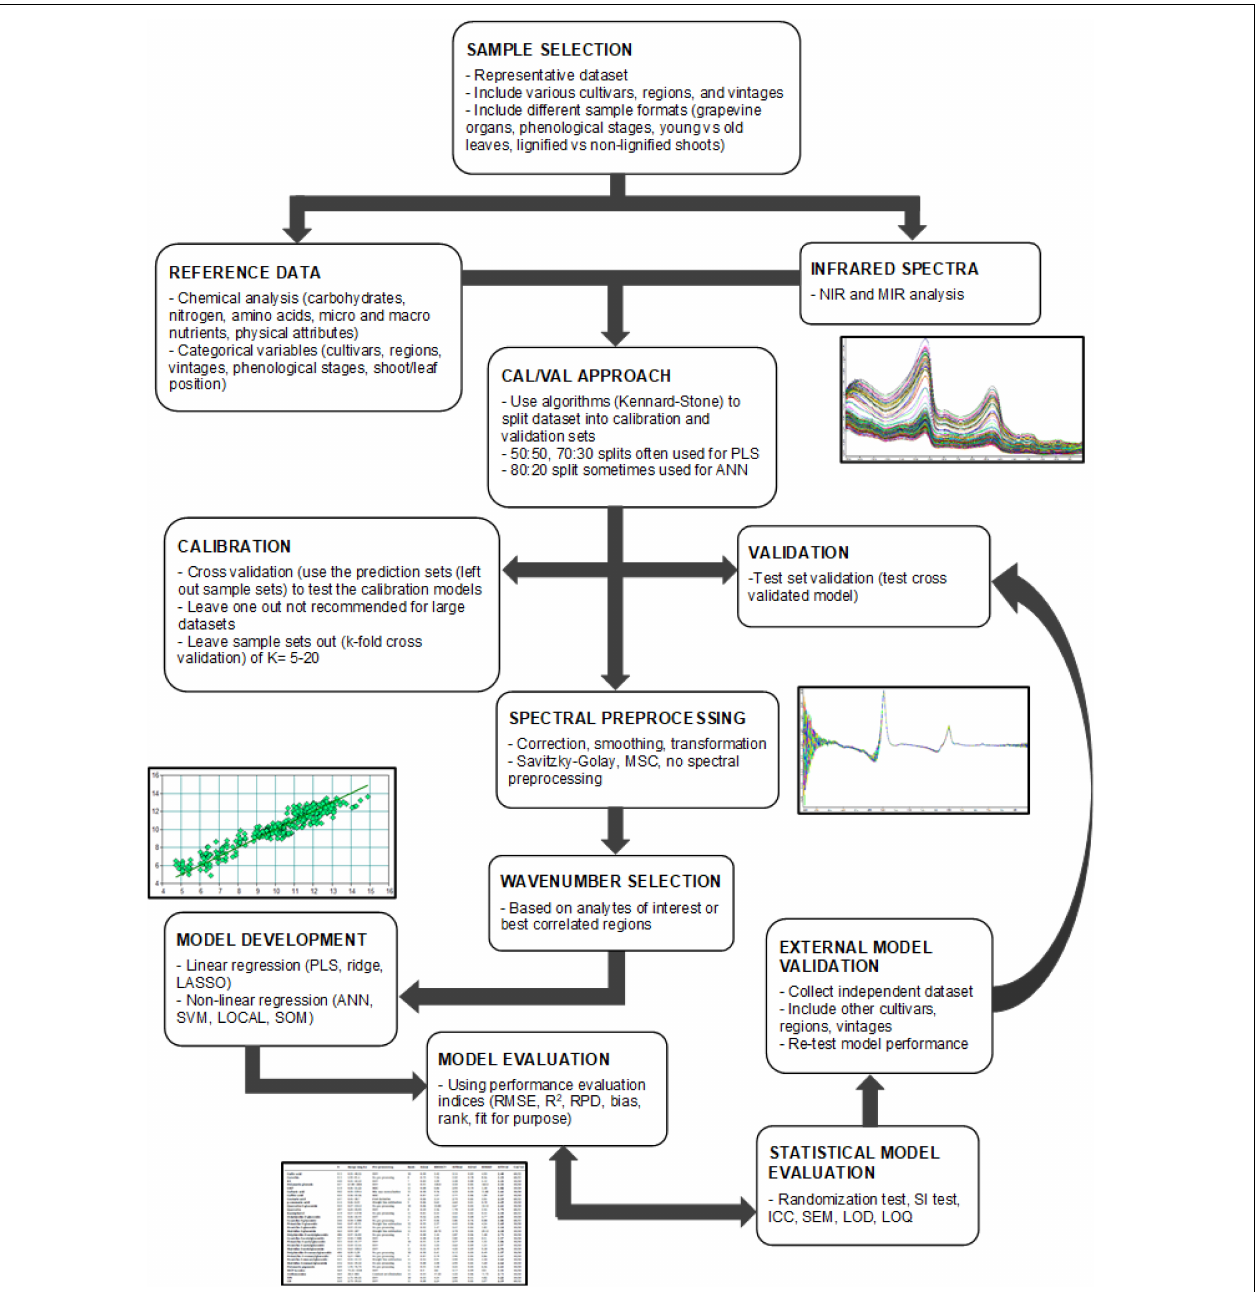
FIGURE 2 | Regression workflow for model development using infrared spectra and grapevine reference data. NIR, near infrared; MIR, mid infrared; PLS, partial least squares; ANN, artificial neural networks; MSC, multiplicative scatter correction; LASSO, least absolute shrinkage and selection; SVM, support vector machines; LOCAL, locally weighted; SOM, Self-organizing maps; RMSE, root mean square error; RPD, residual predictive deviation; SI, slope and intercept; ICC, inter-class correlation coefficient; SEM, standard error of measurement; LOD, limit of detection; LOQ, limit of